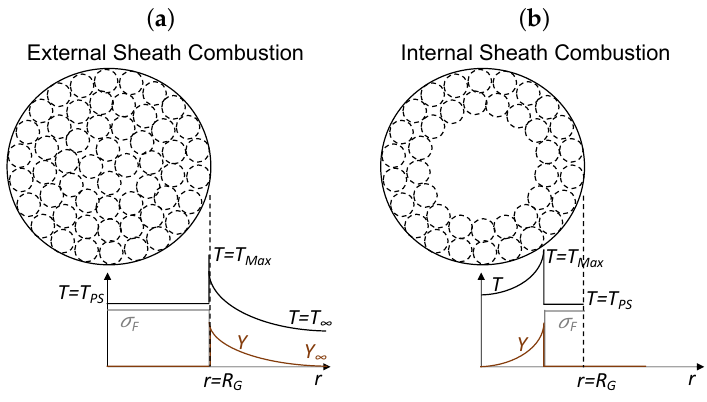
Figure 9. Illustration of external and internal combustion modes of nanothermites.